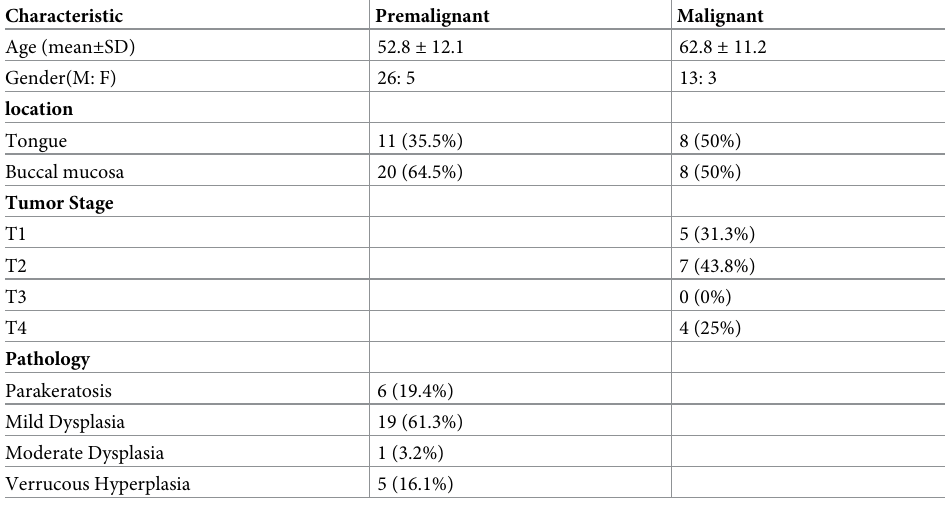
Table 2. Patient